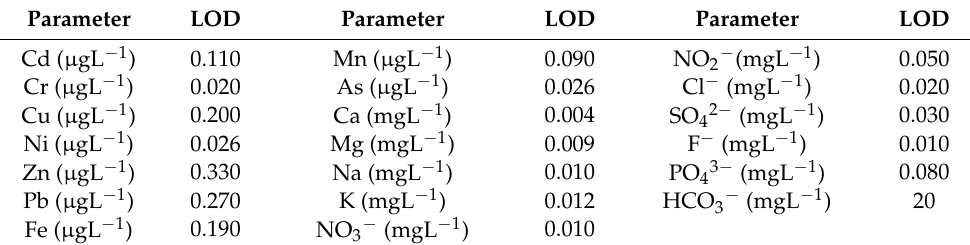
Figure 1. Locations of the investigated areas with the sampling points and the pollution sources in Baia Mare city [40,41]. Table 1. The limit of detection (LOD) of the studied parameters in surface